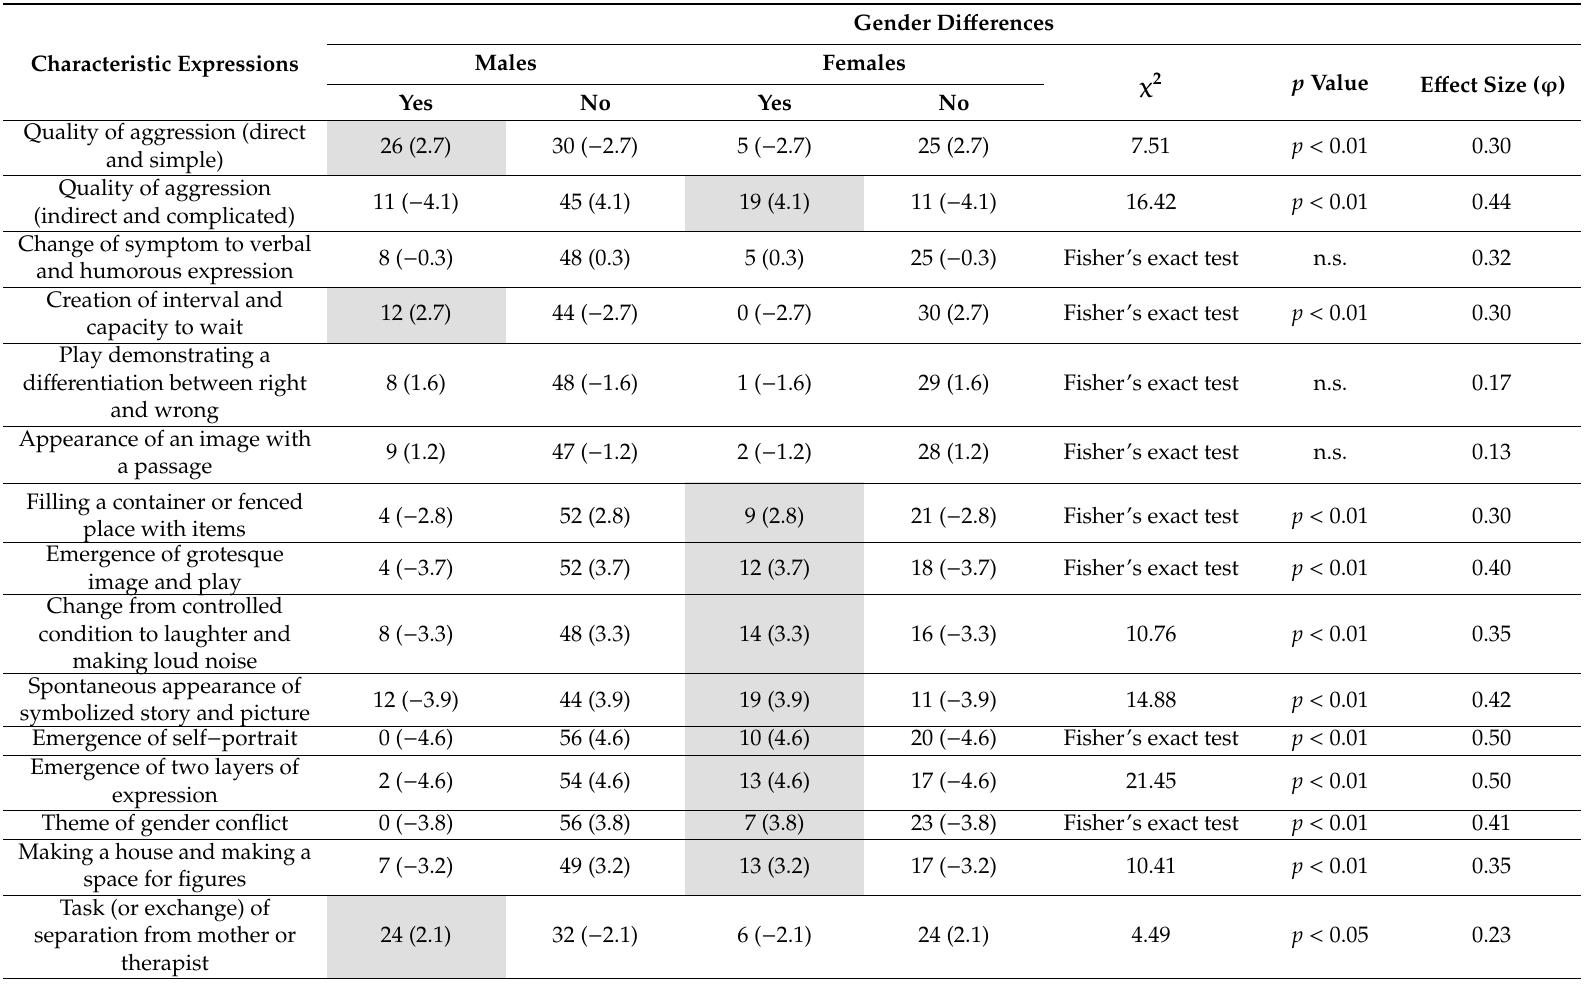
Table 4. The appearance of these characteristic expressions and gender di ff